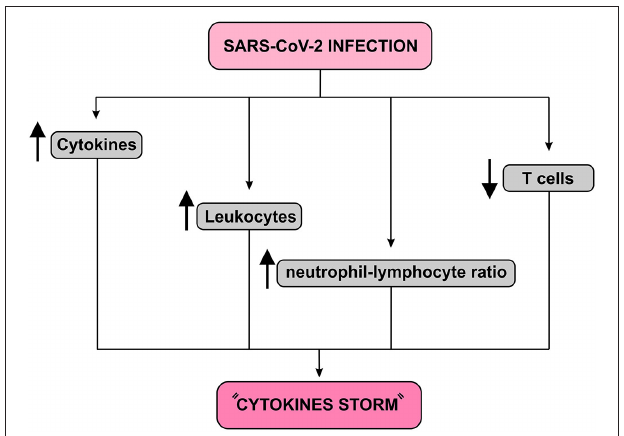
FIGURE 5 | Immune response to SARS-CoV-2 infection diagram. This infection causes a fall in T cells and an increase in leukocyte count and neutrophil-lymphocyte ratio. In addition, it increases the release of cytokines resulting in a condition known as “Cytokines storm,” which may lead to pulmonary edema, severe hypoxia, respiratory failure and, finally, multiple organ